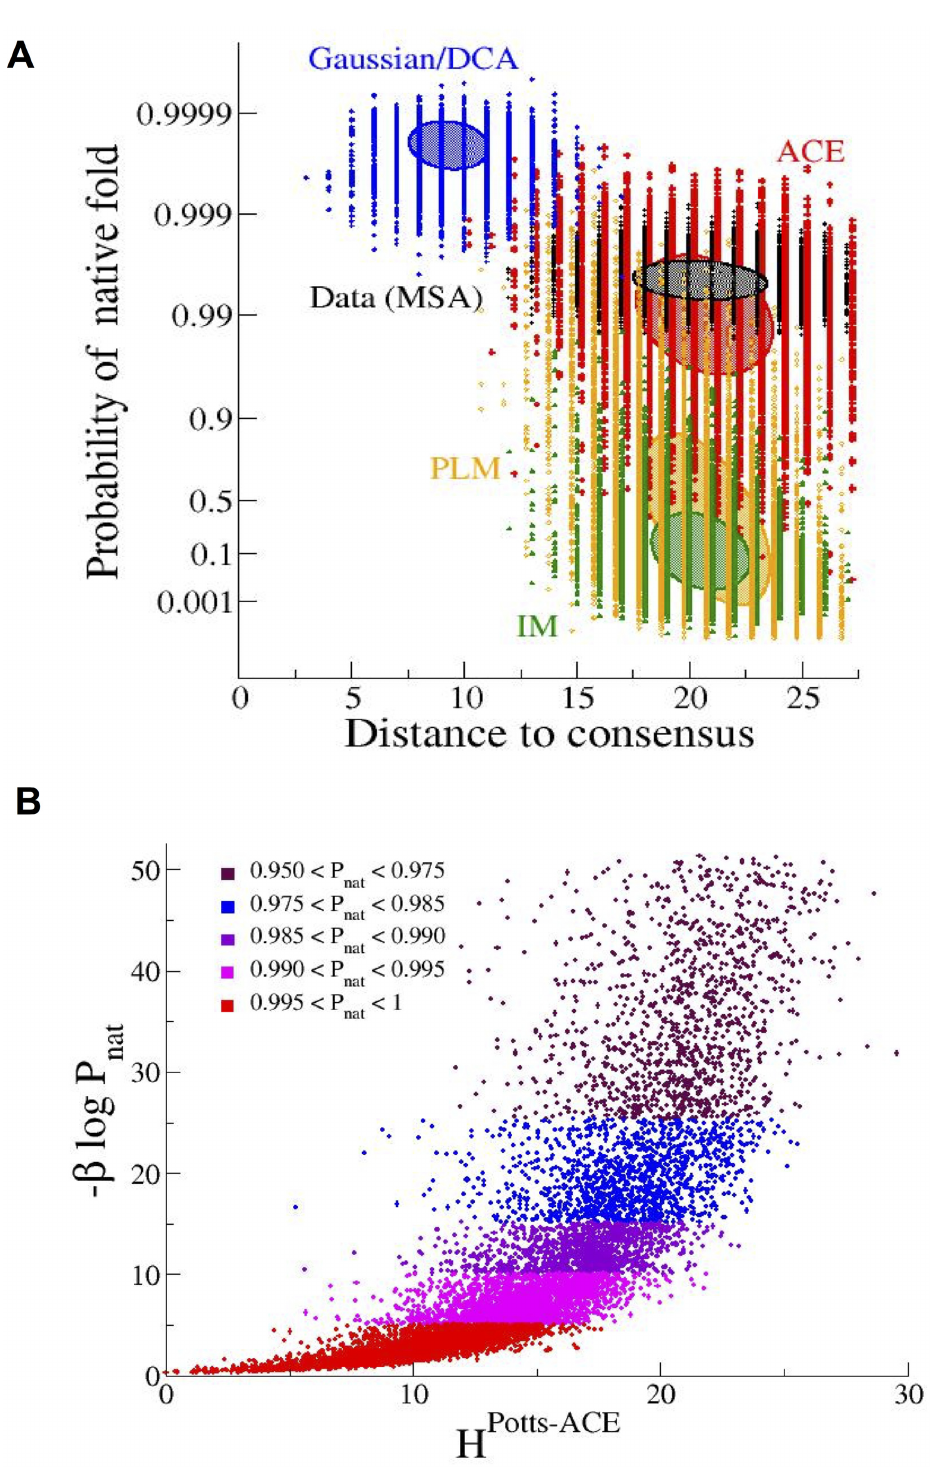
Fig 3. Inferred Potts-ACE model generates sequences with high folding probabilities and diversities. A. Folding probabilities P nat (S B | A ), Eq [5], for four sets of 10 4 sequences A randomly generated with the Independent-site Model (IM, green), the Potts-ACE (red), the Potts-PLM (orange) and the Potts-Gaussian (blue) models vs. their Hamming distances to the consensus sequence of the ‘ natural ’ MSA of structure S B used to infer the four models. Black symbols show results for the ‘ natural ’ sequences, sampled at